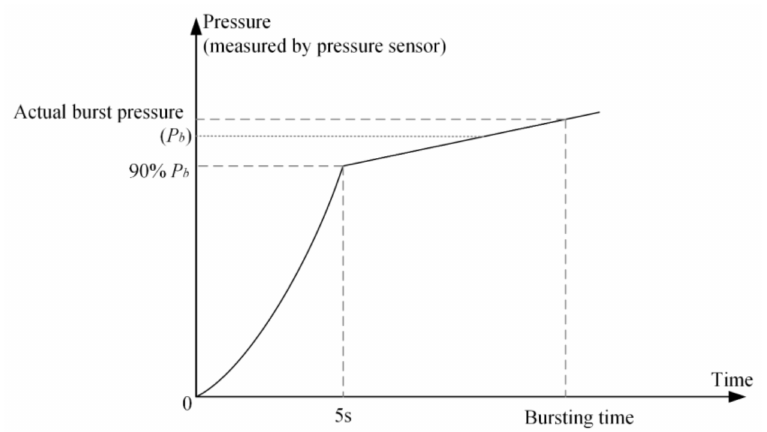
Figure 7. Loading method for the burst pressure of rupture